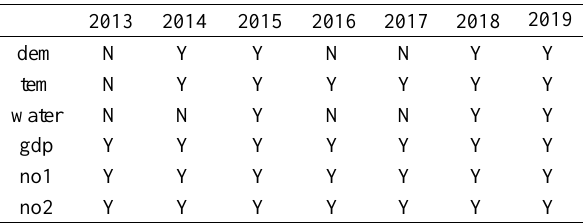
Table 2. Geodetector results of Shanxi Province for